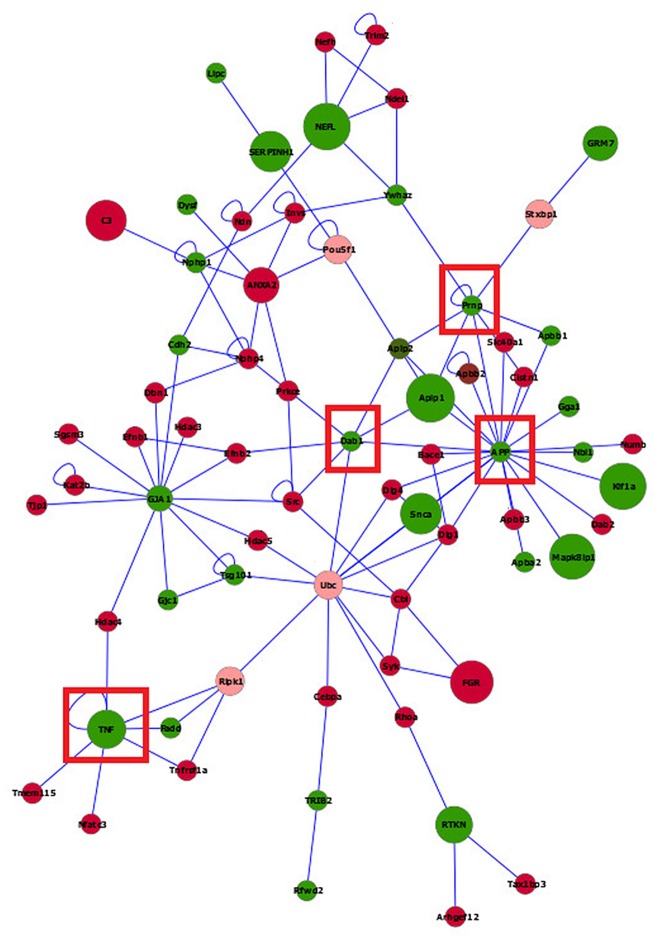
Visualization of the networks of genes differentially expressed between IDO1-knock out (IDO1-KO) and wild type (WT) mice in microglia.Red (green) nodes indicate genes over- (under-) expressed in IDO1-KO relative to wild type. Pink nodes denote a maximum of two intermediate genes between target genes. Node size denotes the P-value (large nodes indicate a more extreme nominal P-value < 0.0001 and small nodes indicate P-value between 0.05 and 0.0001). Edges denote known relationships between genes and framed genes (red square) are discussed.